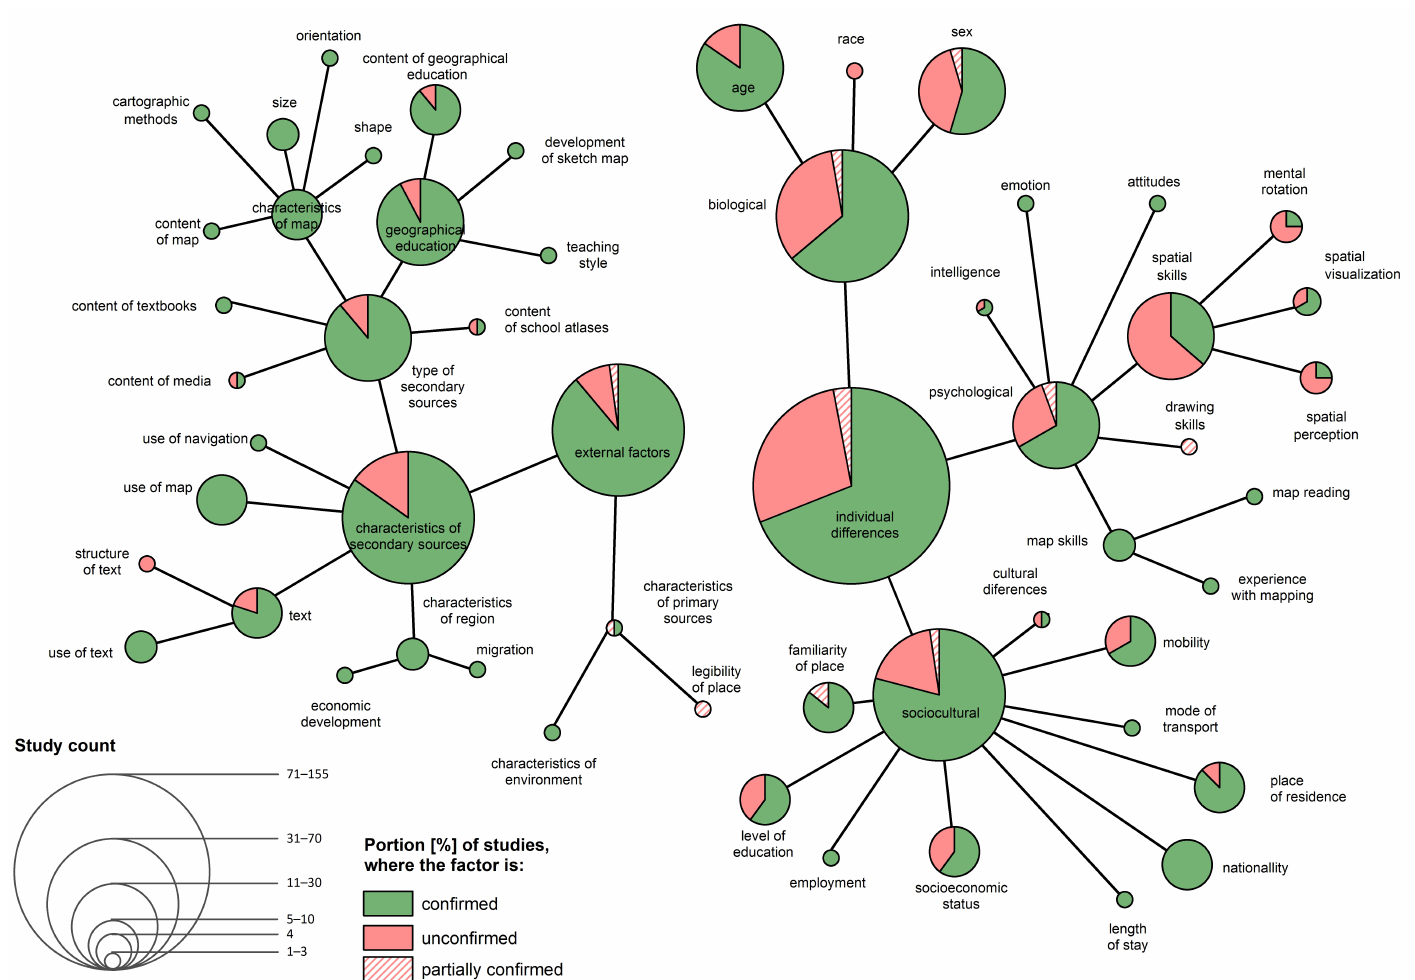
Figure 8. Factors influencing content frequency in sketch